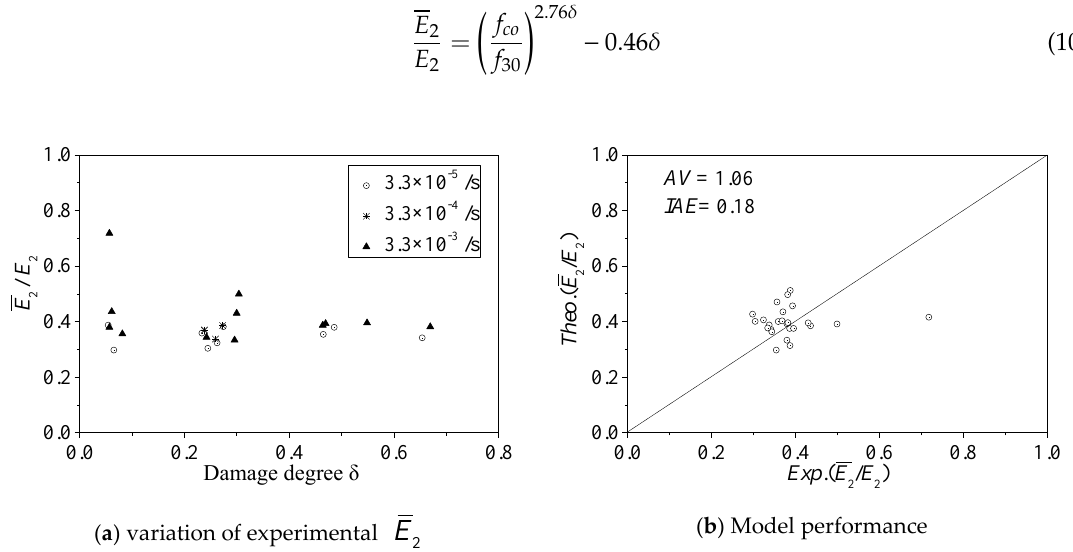
E . Figure 12. Hardening modulus E 2 2